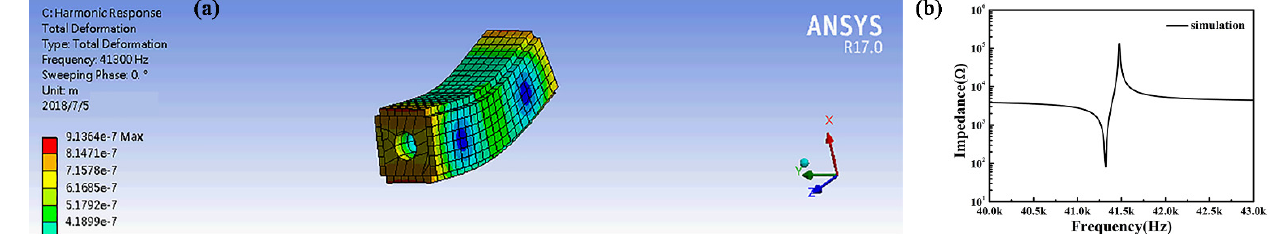
Figure 8. ( a ) The bending simulation result of lead-free piezoelectric motor using ANSYS software; ( b ) The first resonant frequency of lead-free piezoelectric motor with ANSYS Harmonic Response.